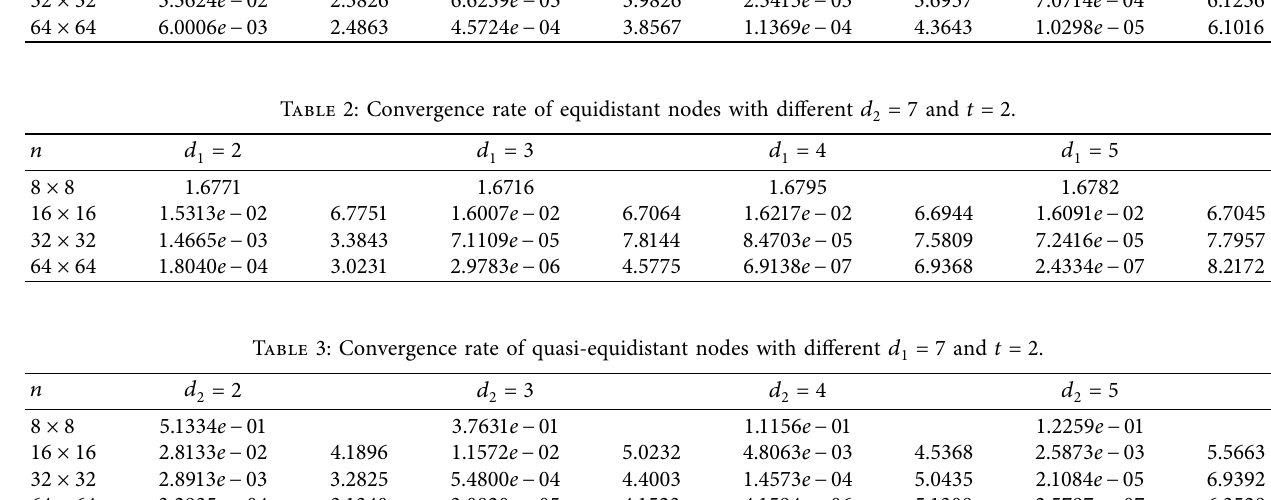
Table 1: Convergence rate of equidistant nodes with different d